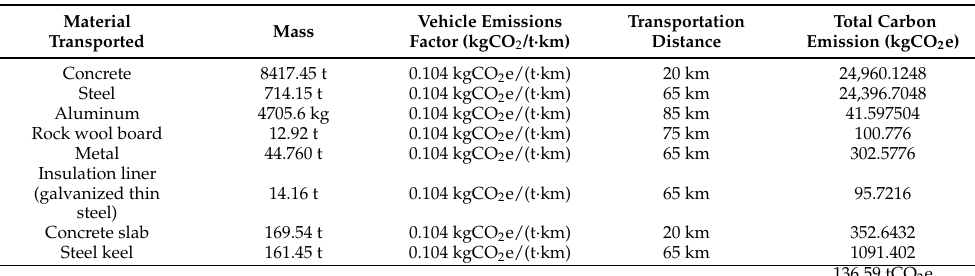
Table 18. Calculation of carbon emissions of transportation of Building B1 in non-prefabricated simu- lation.